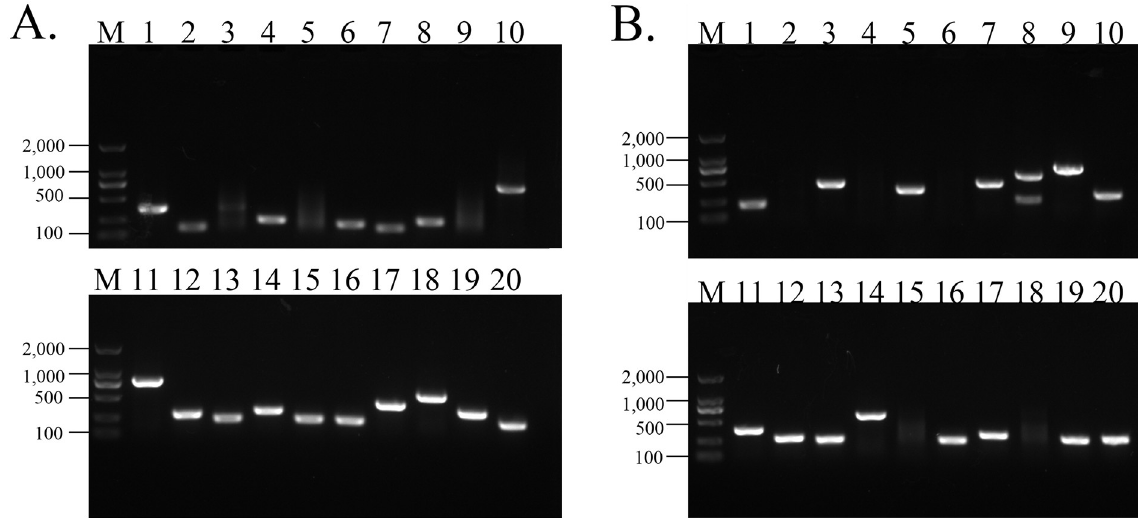
Fig 2. Detection of inserted fragments by bacteria liquid PCR. Electrophoresis with agarose of 1.2% concentration. The images were generated by the Gel imaging system Gel Doc ™ XR+. (A) Treated group. (B) Control group. M represents DNA Marker 2000. The numbers 1, 2, 3, et al. represent different bacterial